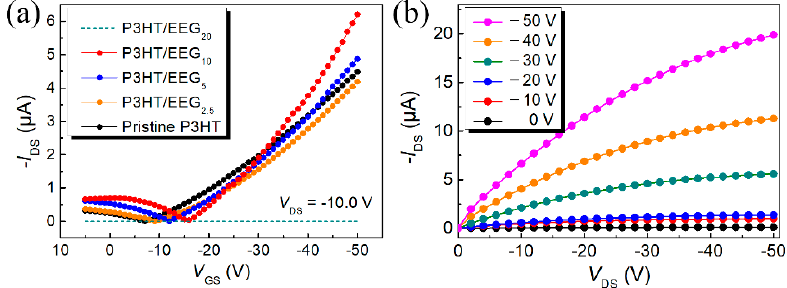
Figure 2. Digital images of fabrication process of ( a ) pristine P3HT and ( b ) P3HT/EEG nanocomposite films via solution floating method.